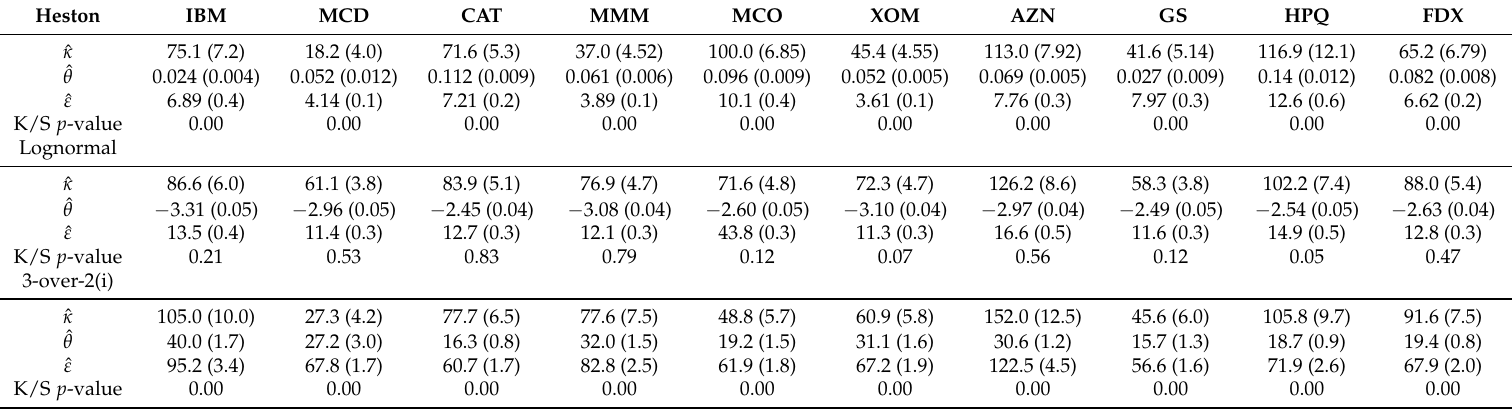
Table 5. Maximum likelihood estimated parameters and standard errors from the realized volatility measured variance with n =